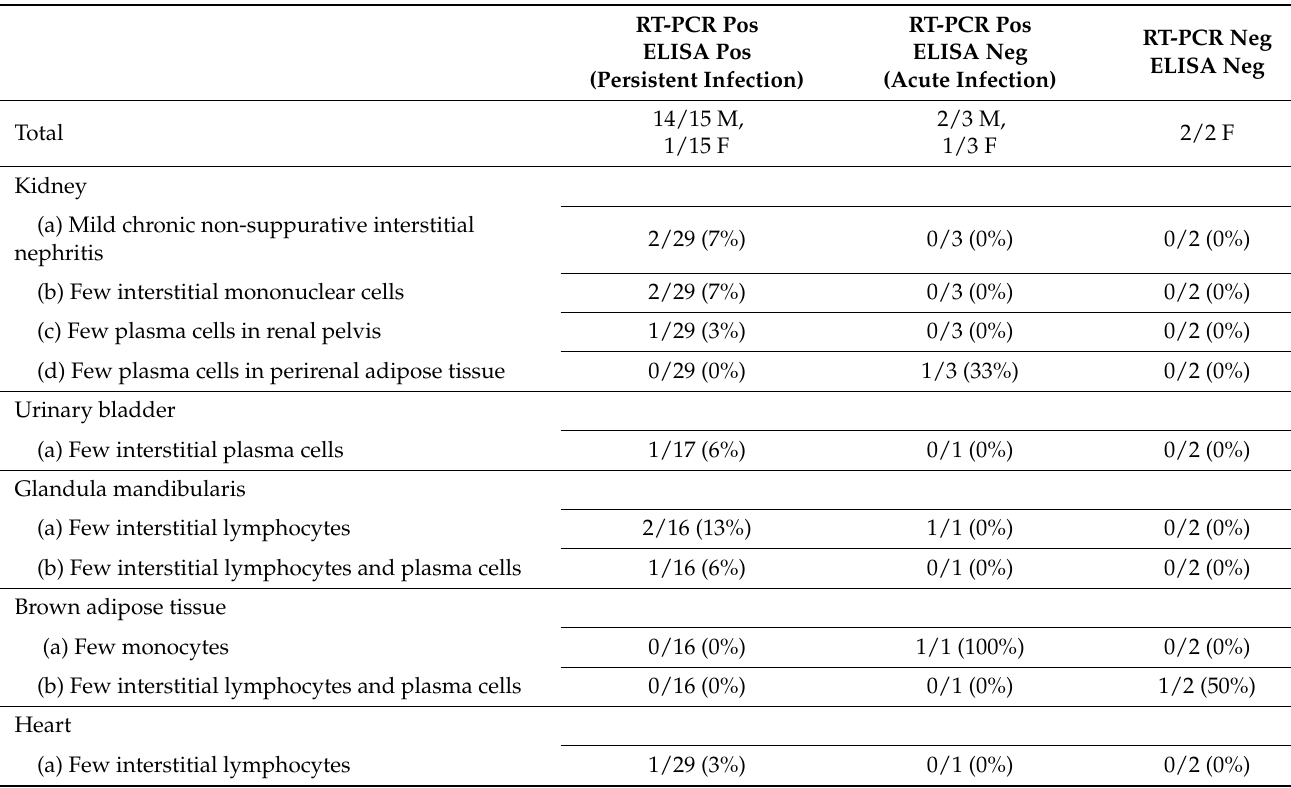
Table 3. Histologic findings in male and female bank voles from